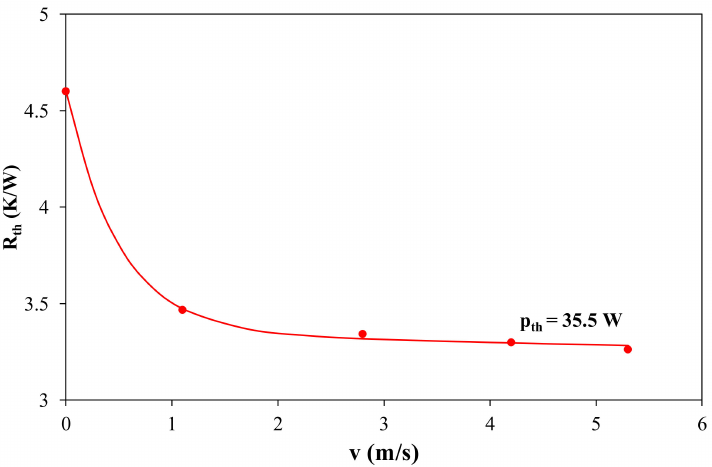
Figure 11. Measured and modelled dependences of the thermal resistance of the resistor placed on the heat sink with a fan on the airflow speed at power p th = 35.5 W (system B).